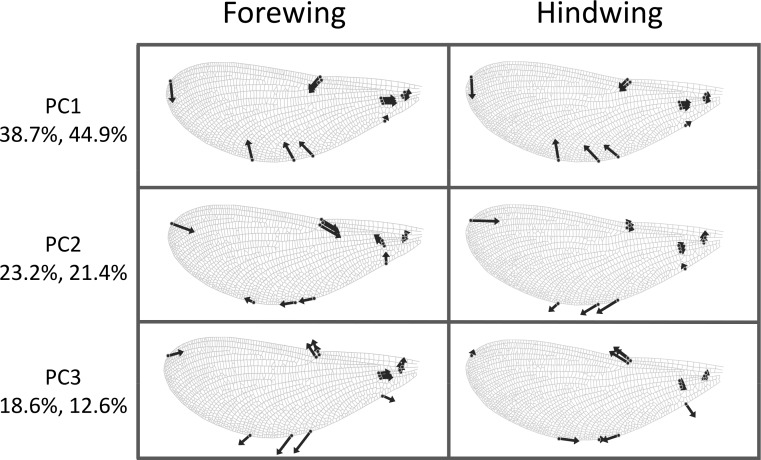
Shape variation in Calopteryx maculata wings.Deformation plots showing the effect of increasing the value of each principal component on the relative locations of wing landmarks. Arrows indicate the direction and extent of change. Percentages are the percentage of variation explained by each principal component for fore and hind wings, respectively.